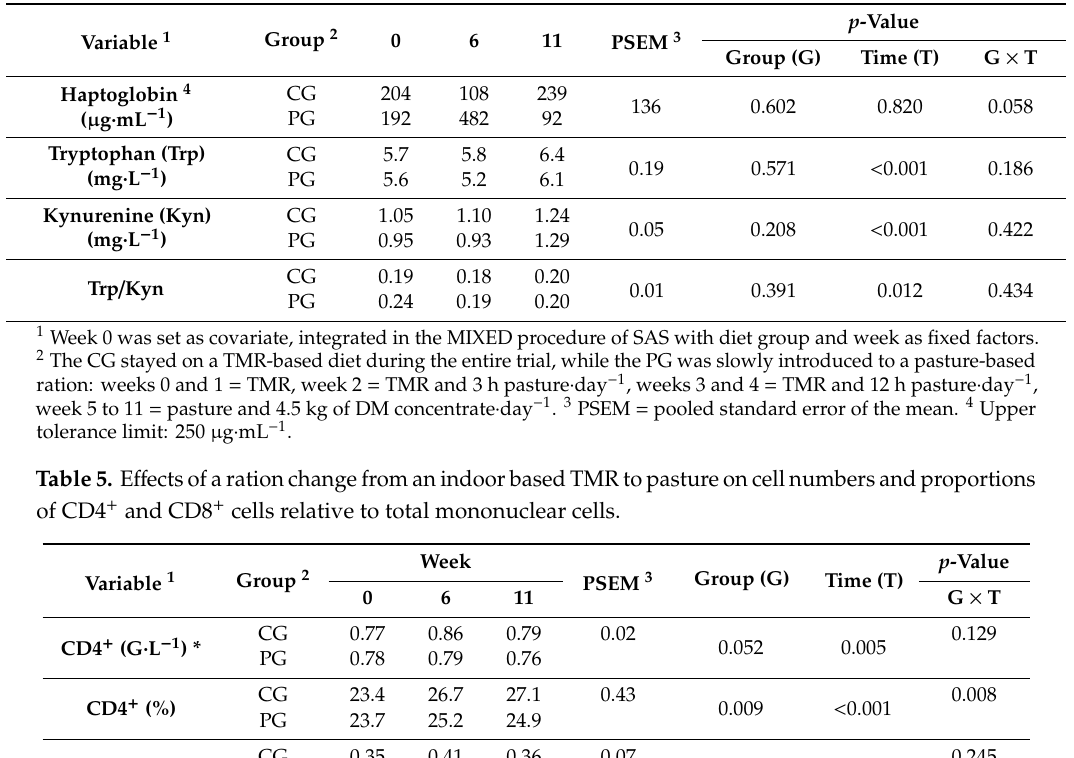
Table 4. E ff ect of a ration change from TMR to pasture on blood variables: haptoglobin, tryptophan (Trp) and kynurenine (Kyn).